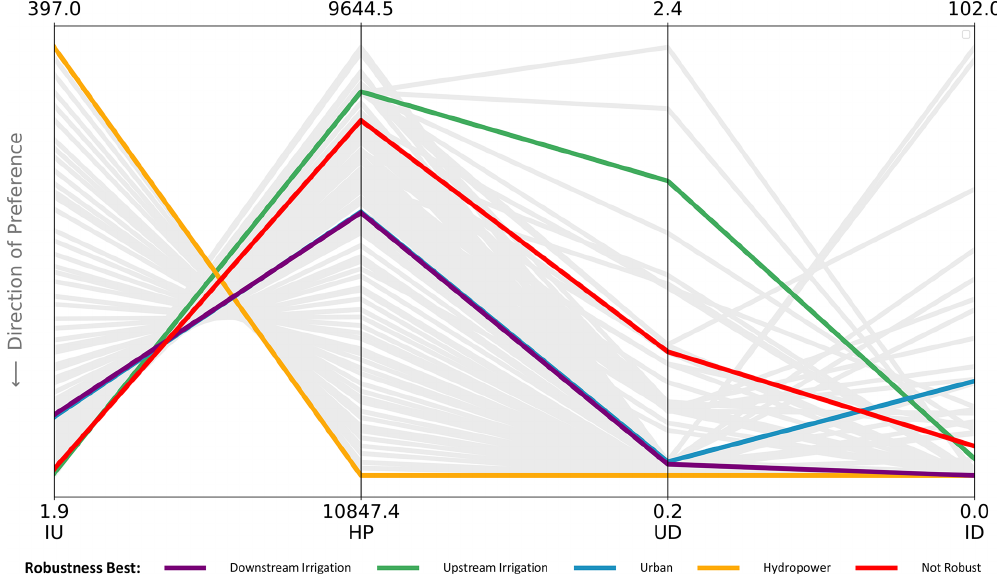
Figure 5. Policy performance across sectors under the baseline scenario. IU is the upstream irrigation, HP is the hydropower, UD is the urban deficit, and ID is the irrigation